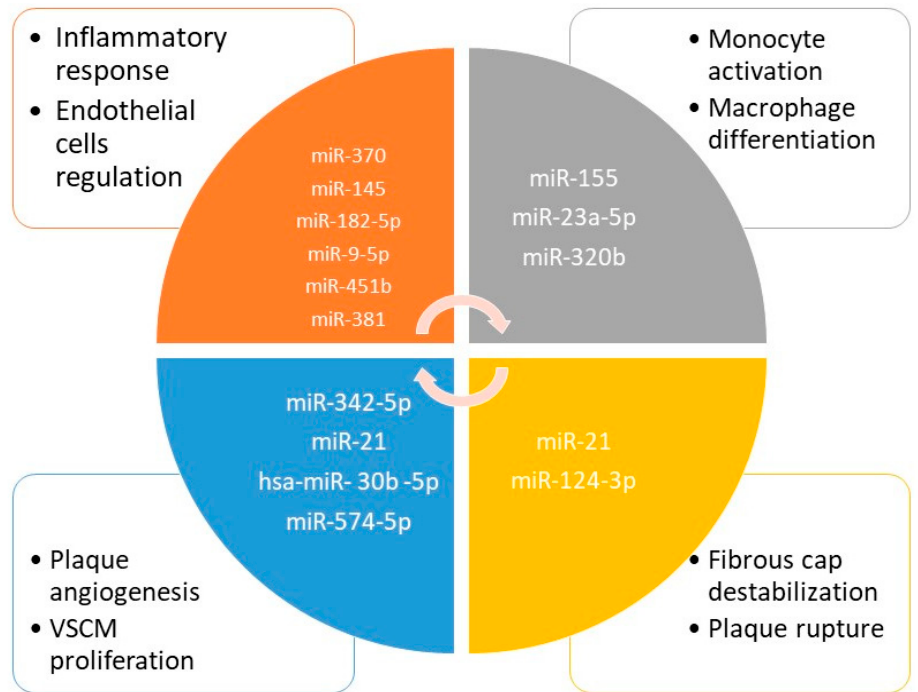
Figure 2. Potential role of miRNA as biomarkers of vulnerable plaque in coronary artery